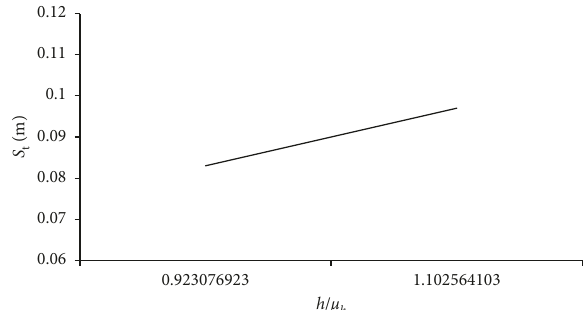
Figure 6: Effect of soil thickness on the final consolidation settlement.